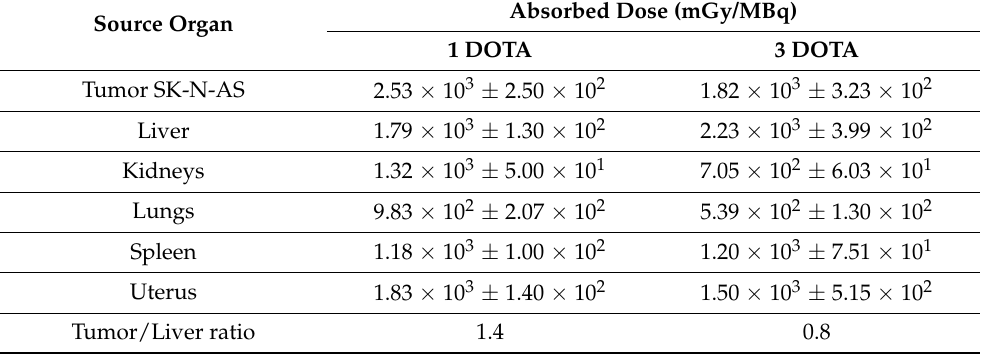
Table 4. Mouse dosimetry comparison between [ 177 Lu]Lu-1C1m-Fc conjugated with 1 or 3 DOTA. The selected organ of interested are the TEM-1 positive tumor, the liver, the kidneys, the lungs, the spleen and the